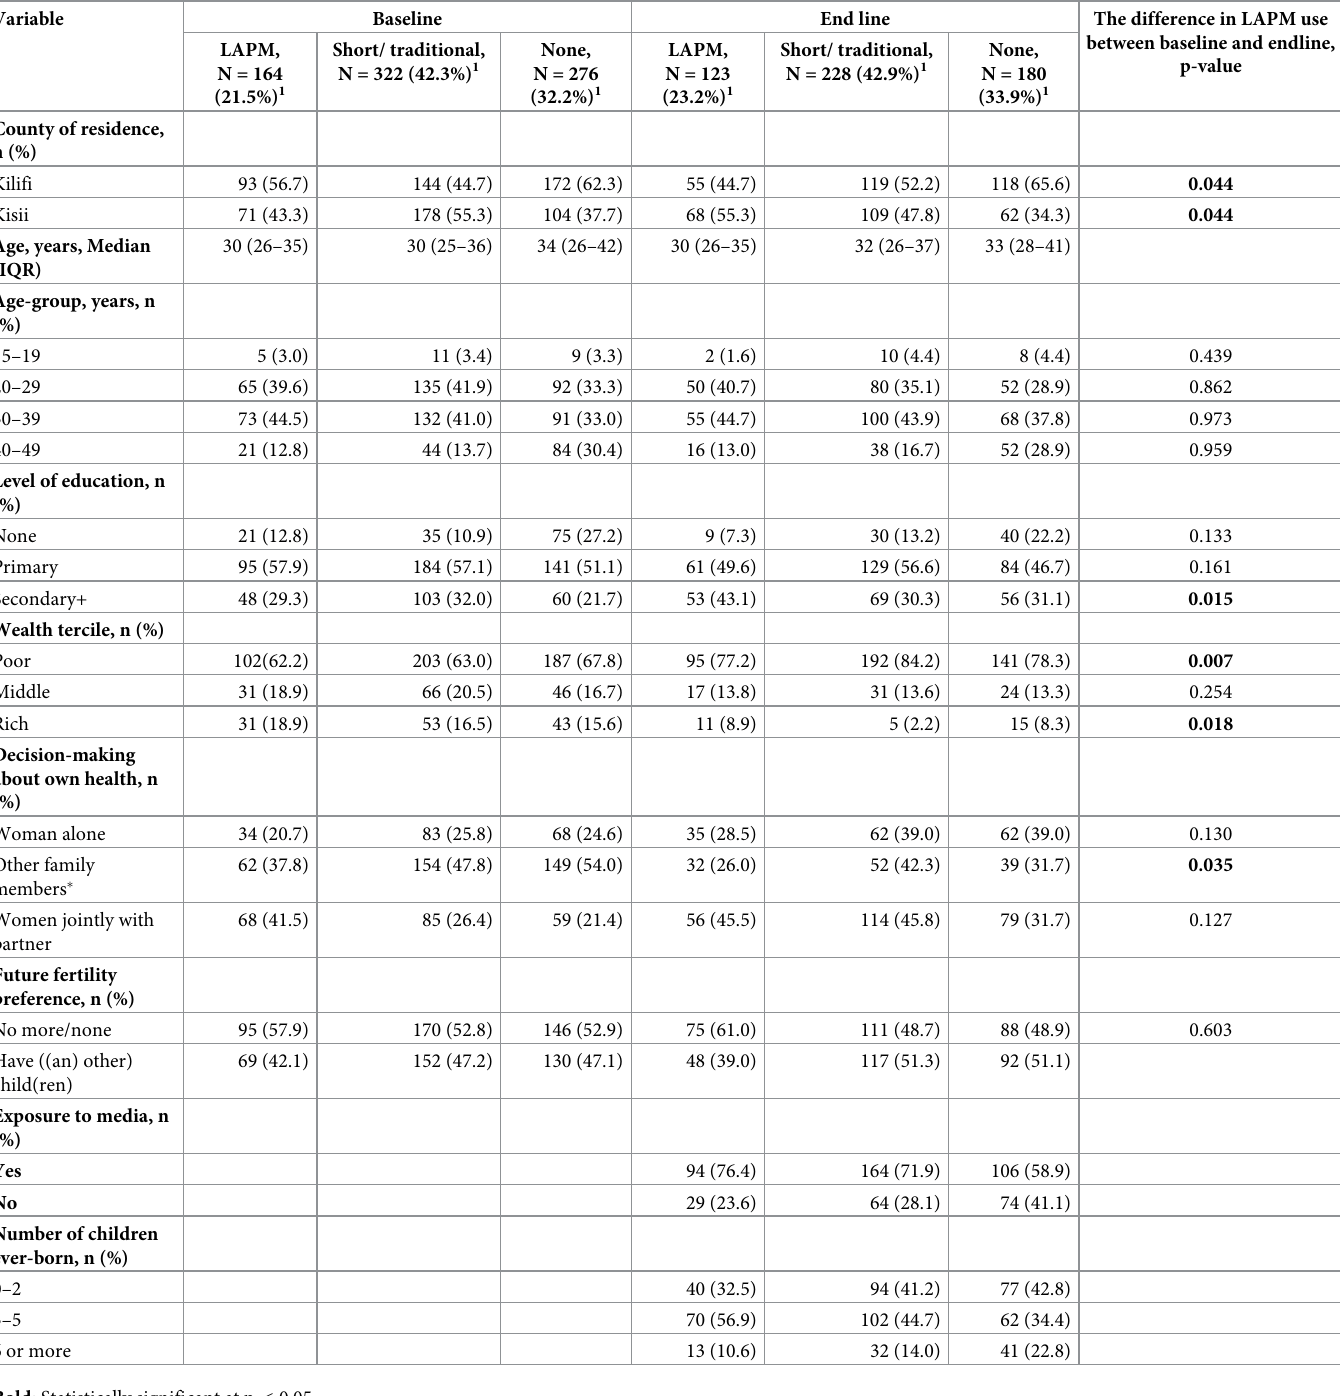
Table 2. Prevalence of contraceptive use according to participants’ characteristics at baseline and end line